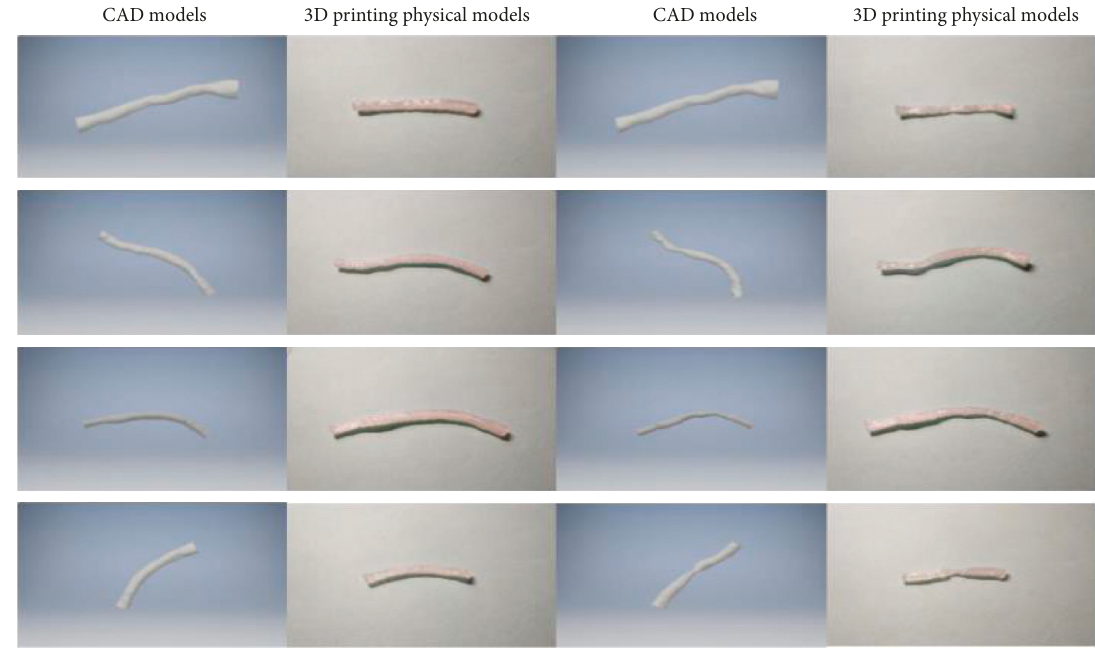
Figure 8: Comparison of 8 selected coronary artery CAD models and 3D printing physical